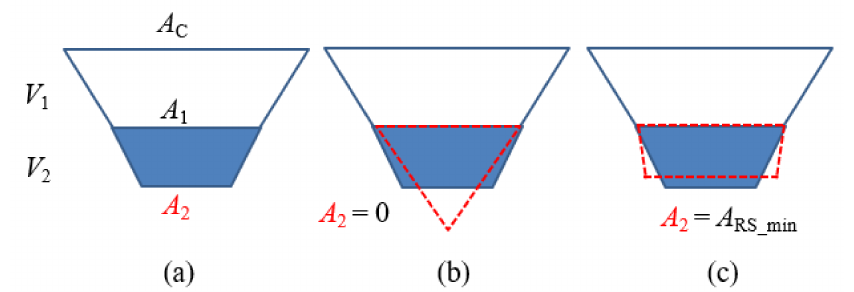
Figure 7. Illustration of the process for quantifying the uncertainty associated with the extrapolation of the A - H relationship: ( a ) an example of a simplified reservoir cross section, with a bottom area of A 2 identified by assuming the unmeasured portion shares the same A-H relationship, ( b ) the reservoir cross section by assuming the bottom area A 2 is 0, ( c ) the reservoir cross section by assuming the reservoir bottom area A 2 equals A RS_min